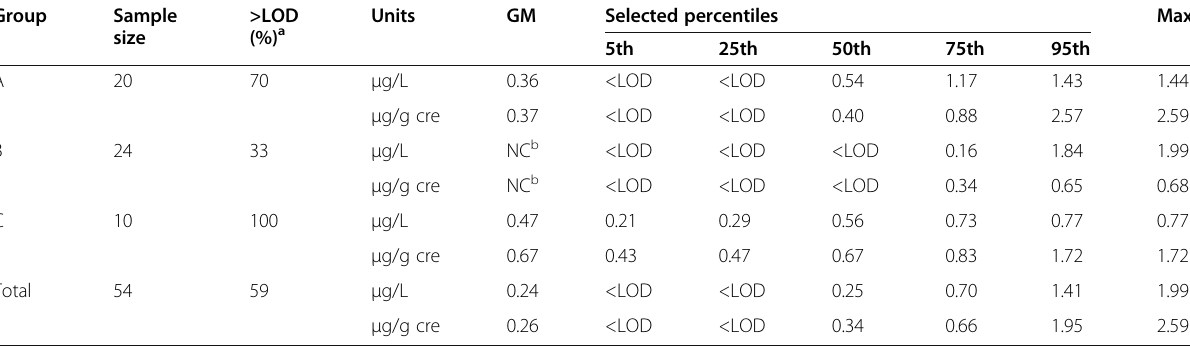
Table 6 Detection rates, geometric means, and percentiles of urinary glyphosate concentrations Group Sample